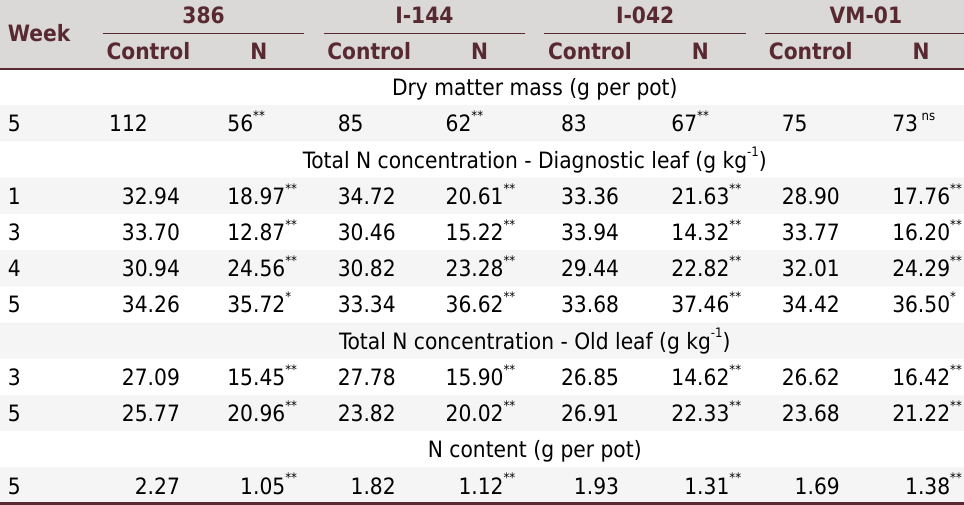
Table 2. Dry matter weight, concentration total nitrogen in diagnostic and old leaf, and nitrogen content in eucalypt clones (386, I-144, I-042 and VM-01) subjected to nitrogen omission (weeks 1 and 3) and N resupply (weeks 4 and 5) and control